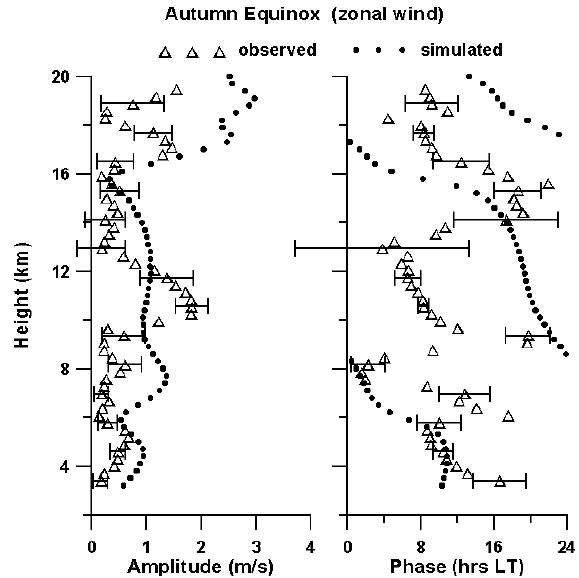
Fig. 3. Vertical profiles of amplitude (left panel) and phase (right panel) of diurnal tides in zonal winds observed over Gadanki (open triangles) during the autumn equinox season. Amplitudes and phases simulated by classical tidal theory for the location of Gadanki (same simulation for all seasons) are also shown (filled cir- cles). The rms errors in amplitudes and phases at ∼ 1 km intervals are shown by horizontal